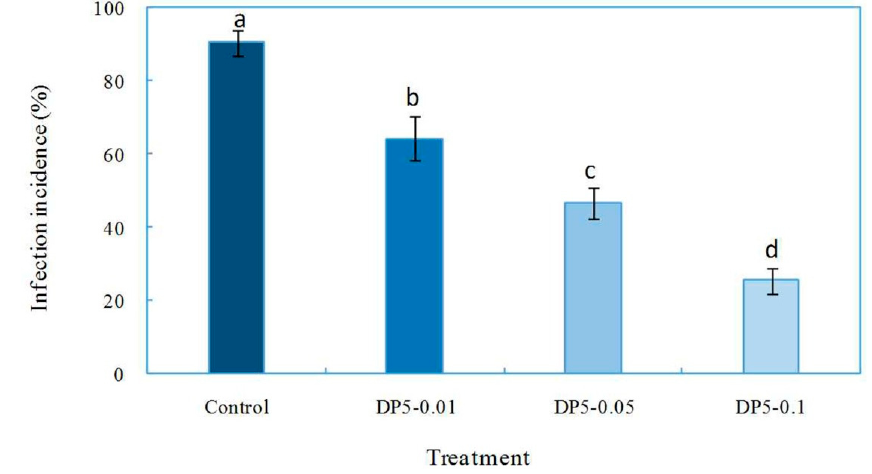
Figure 6. Inhibitory effects of oligochitosan DP5 on Fusarium sambucinum infection of Zanthoxylum bungeanum stems. Different letters (a–d) indicate significant differences at the level of p < 0.05 in the incidence of infection with various DP5 treatments. DP5–0.01, DP5–0.05, and DP5–0.1 indicate DP5 concentrations of 0.01, 0.05, and 0.1 mg/mL, respectively.